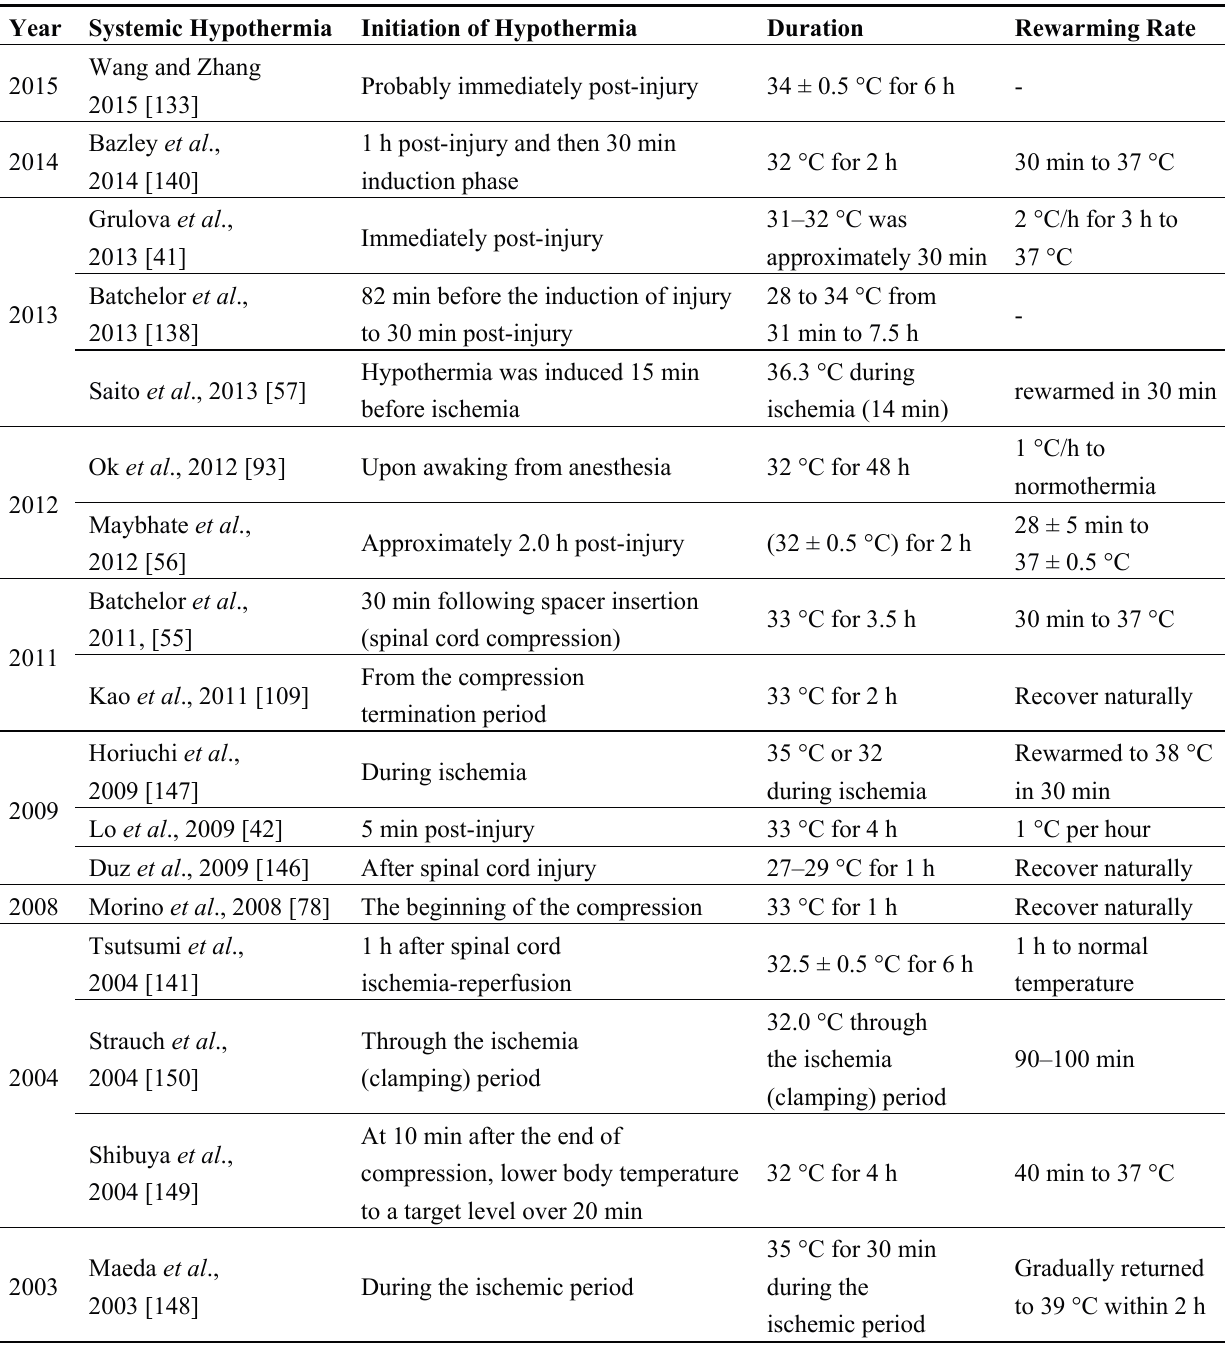
Table 2. Initiation, duration and rewarming rate for systemic hypothermia in experimental SCI